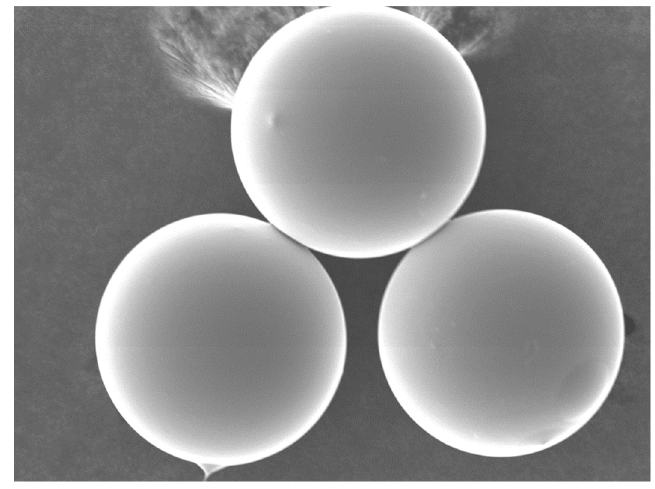
Figure 4. SEM micrographs of single resin beads.